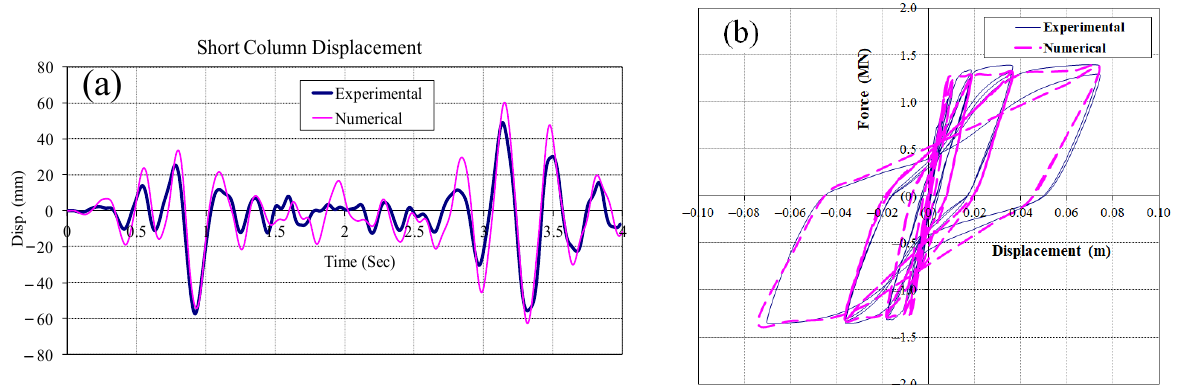
Figure 4. Comparison of the experimental data for the short column of the bridge B213C tested by Pinto et al. [51] and results from numerical analysis: ( a ) column displacement for the maximum earthquake and ( b ) cyclic response of the column.